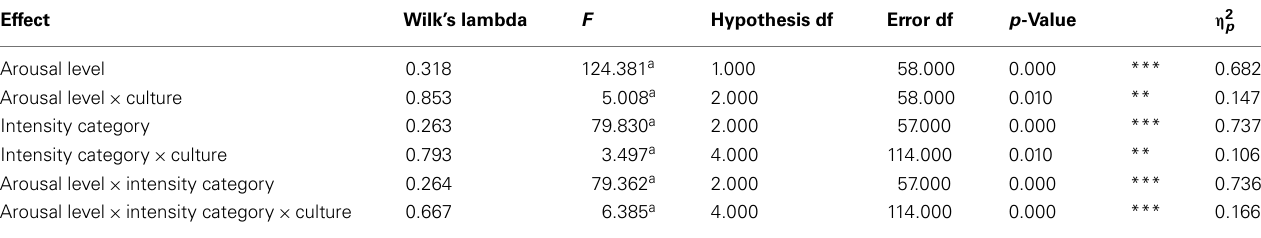
TableA2 | Omnibus MANOVA for mean ipsatized